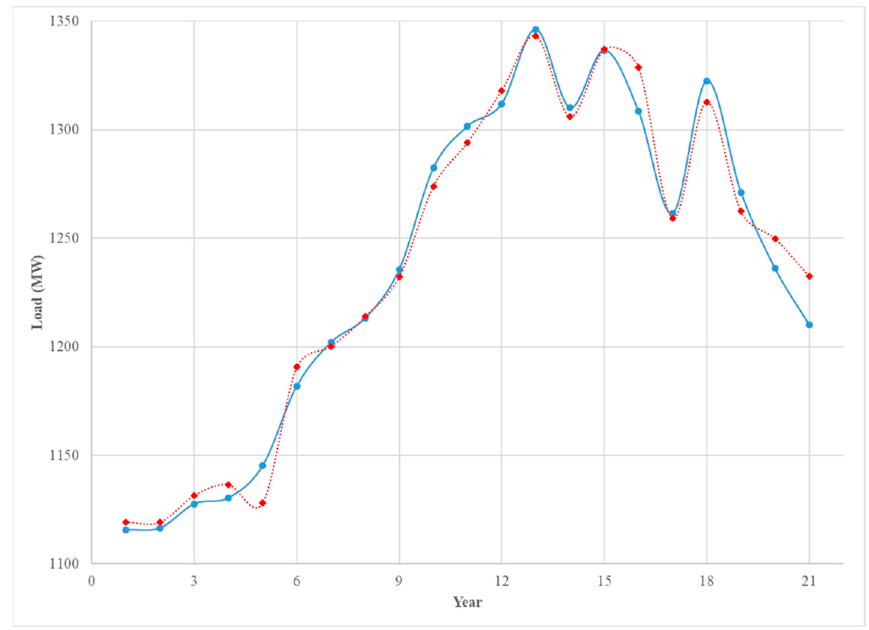
Figure 7. The annual average of hourly load (blue solid) and the predicted load (red doted) 1993–2013.